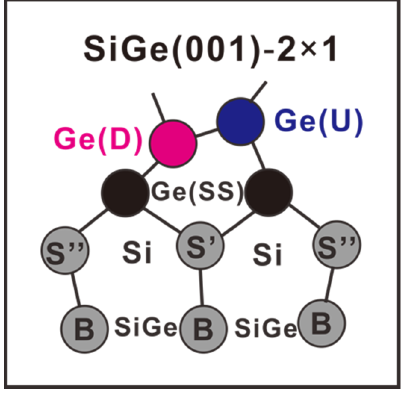
Figure 10. Schematic drawing of Si 1− x Ge x (001)-2×1, which is good for samples grown on the Ge(001) and Si(001) substrates irrespective of the Ge contents. Symbols Ge(D), Ge(U), and Ge(SS) stand for the up-dimer Ge atoms, the down-dimer Ge atoms, and the Ge atoms in the subsurface layer, respectively. Symbols S’ and S” stand for Si atoms in the third surface layer. The symbol B stand for Si and Ge atoms in the bulk of SiGe film.